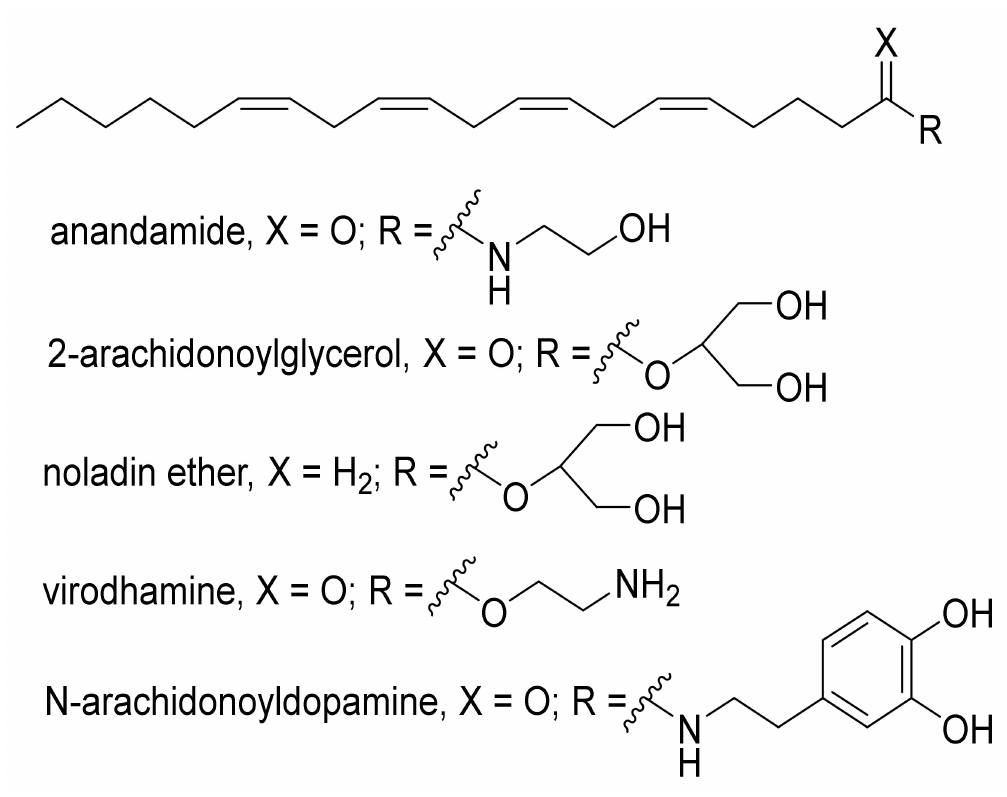
Figure 2. Structures of the main endocannabinoids